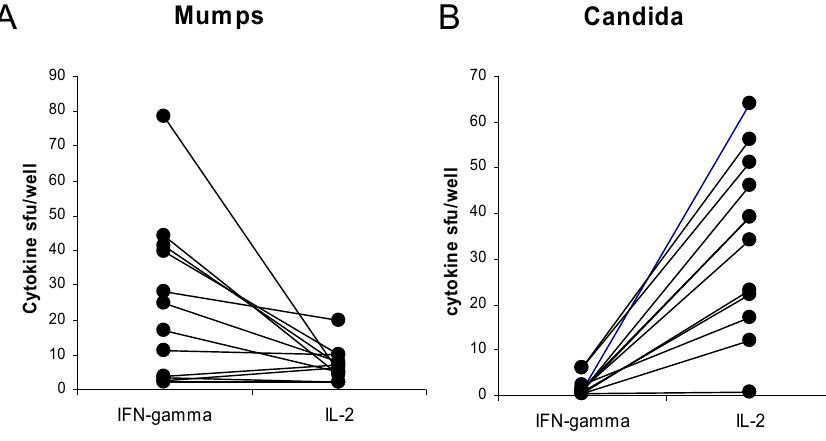
Figure 1. Antigen-specific CD4 and CD8 memory cells show dissociated production of IL- 2 and IFN- γ . Healthy subject (n = 22) PBMC ( panels A–C ) or CD4 vs. CD8 depleted PBMC ( panel D ) (300,000 cells per well) were challenged in 20 h culture with recall protein (mumps or candida) or peptide (EBV BMLF-1, EBNA3a, or EBNA3b) antigen and IFN-  /IL-2 producing cell frequency was measured by ELISPOT method. Assays were performed in triplicate. For panels A–C each line represents a separate subject (n = 12). Panel D , CD4 vs. CD8 depletion analysis reveals immune response phenotype. Spot forming units (sfu) observed with PBMC (300,000 cells per well) were assigned as